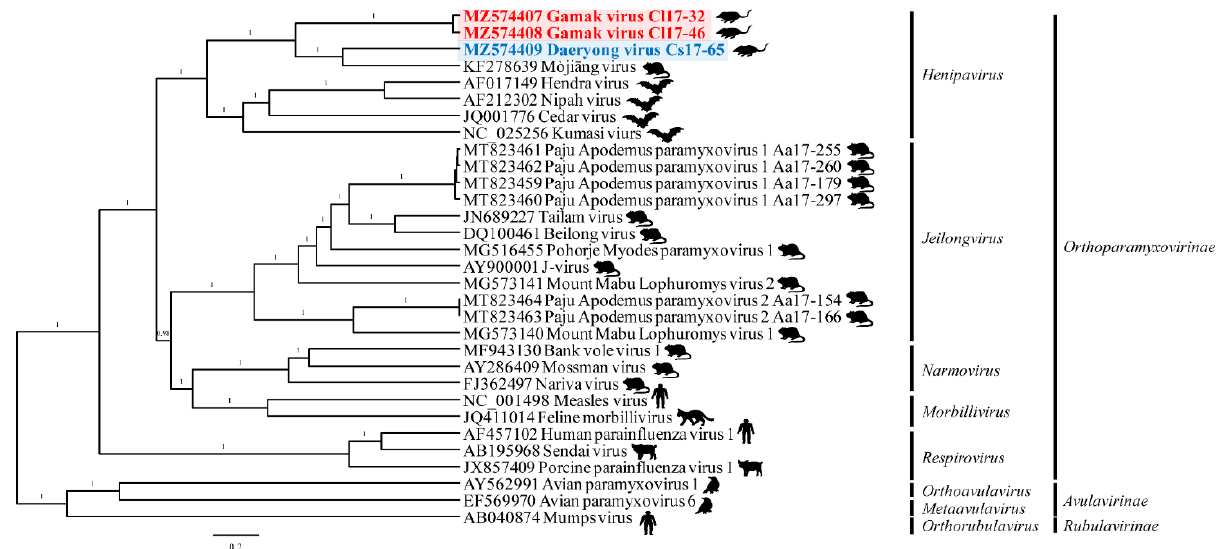
Figure 4. A phylogenetic tree of Gamak virus, Daeryong virus, and multiple paramyxoviruses using nearly whole-genome sequences. Phylogenetic inferences were conducted by BEAST (v1.10.4) with default priors and assuming homochromous tips. The Markov chain Monte Carlo analysis was run until sufficient sample sizes (ESS > 200) were acquired. The maximum clade credibility tree from the posterior tree distribution was summarized byTreeAnnotator (v2.5.4), using a 10% burn-in. Paramyxoviridae strains were utilized as reference sequences for this phylogenetic analysis. Red and blue bold texts indicate GAKV and DARV, respectively.